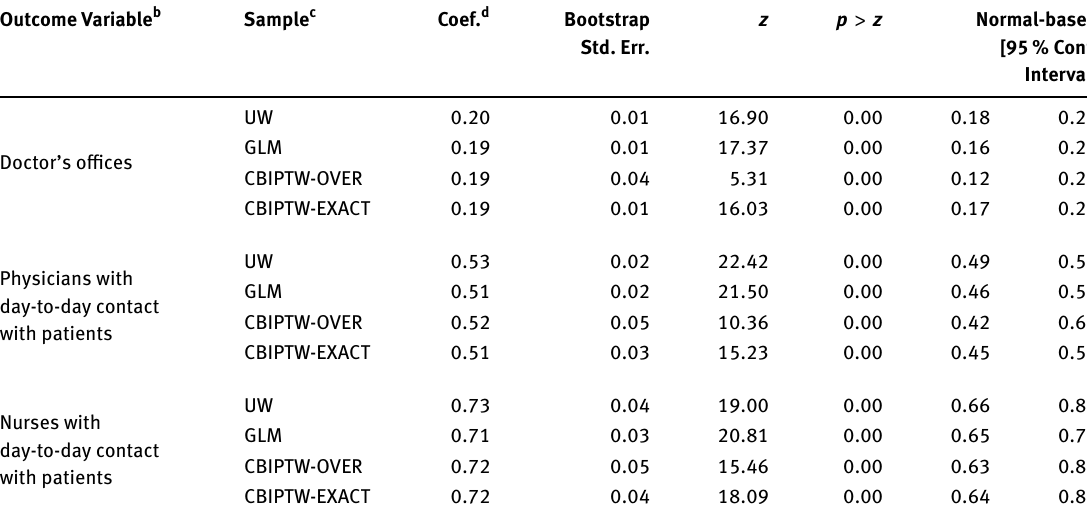
Table A.2: Average Treatment Effect of SP coverage on Sanitary Jurisdictions a . Outcome Variable